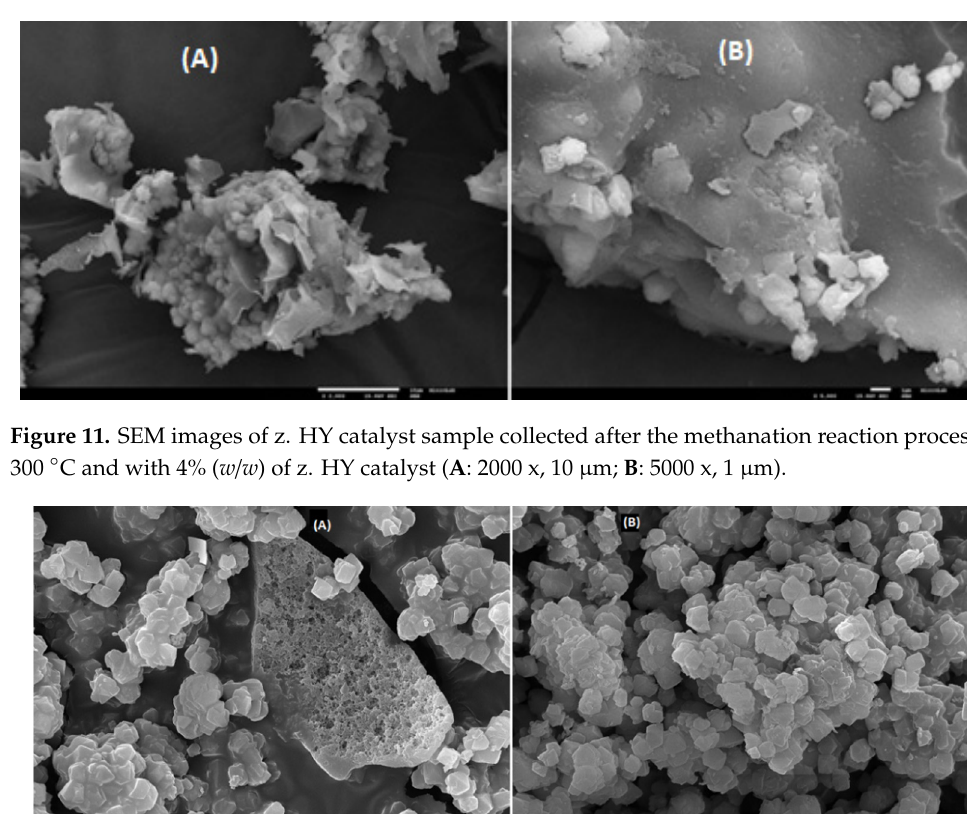
Figure 12. SEM images (5000 x; 1 µ m) of: ( A ) z. HY catalyst sample collected before the activation process; ( B ) same catalyst sample collected after the activation process.